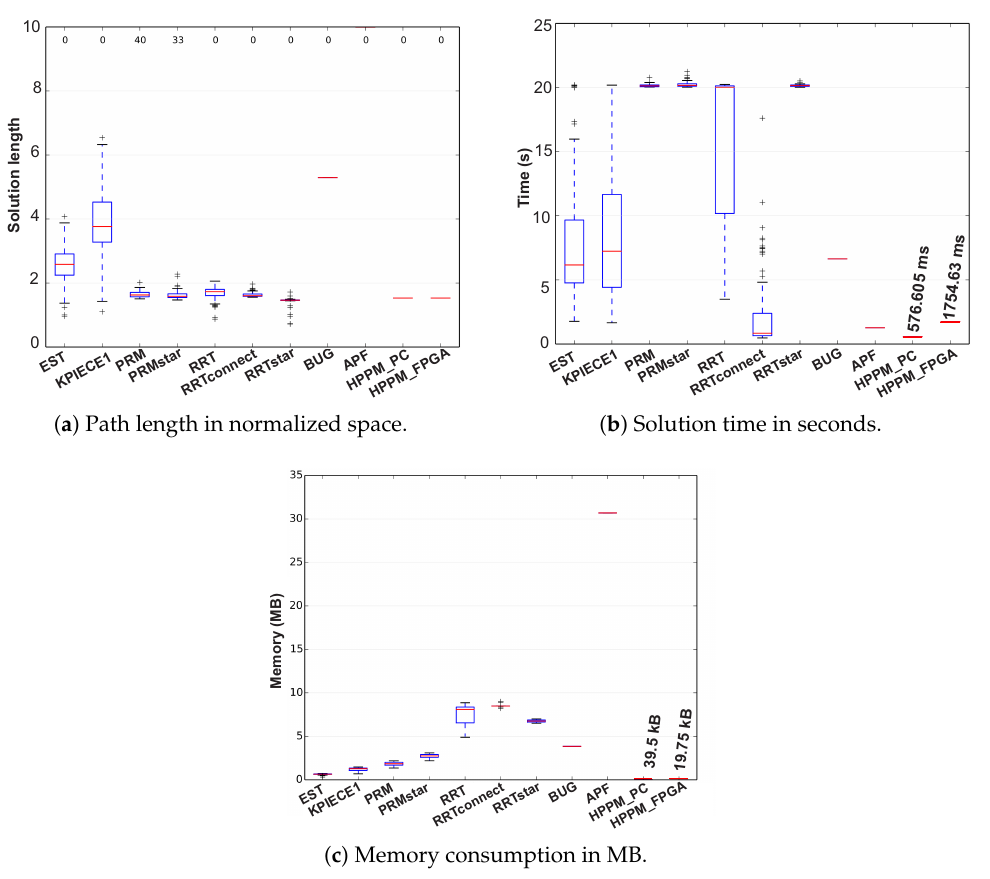
Figure 20. 200 obstacles